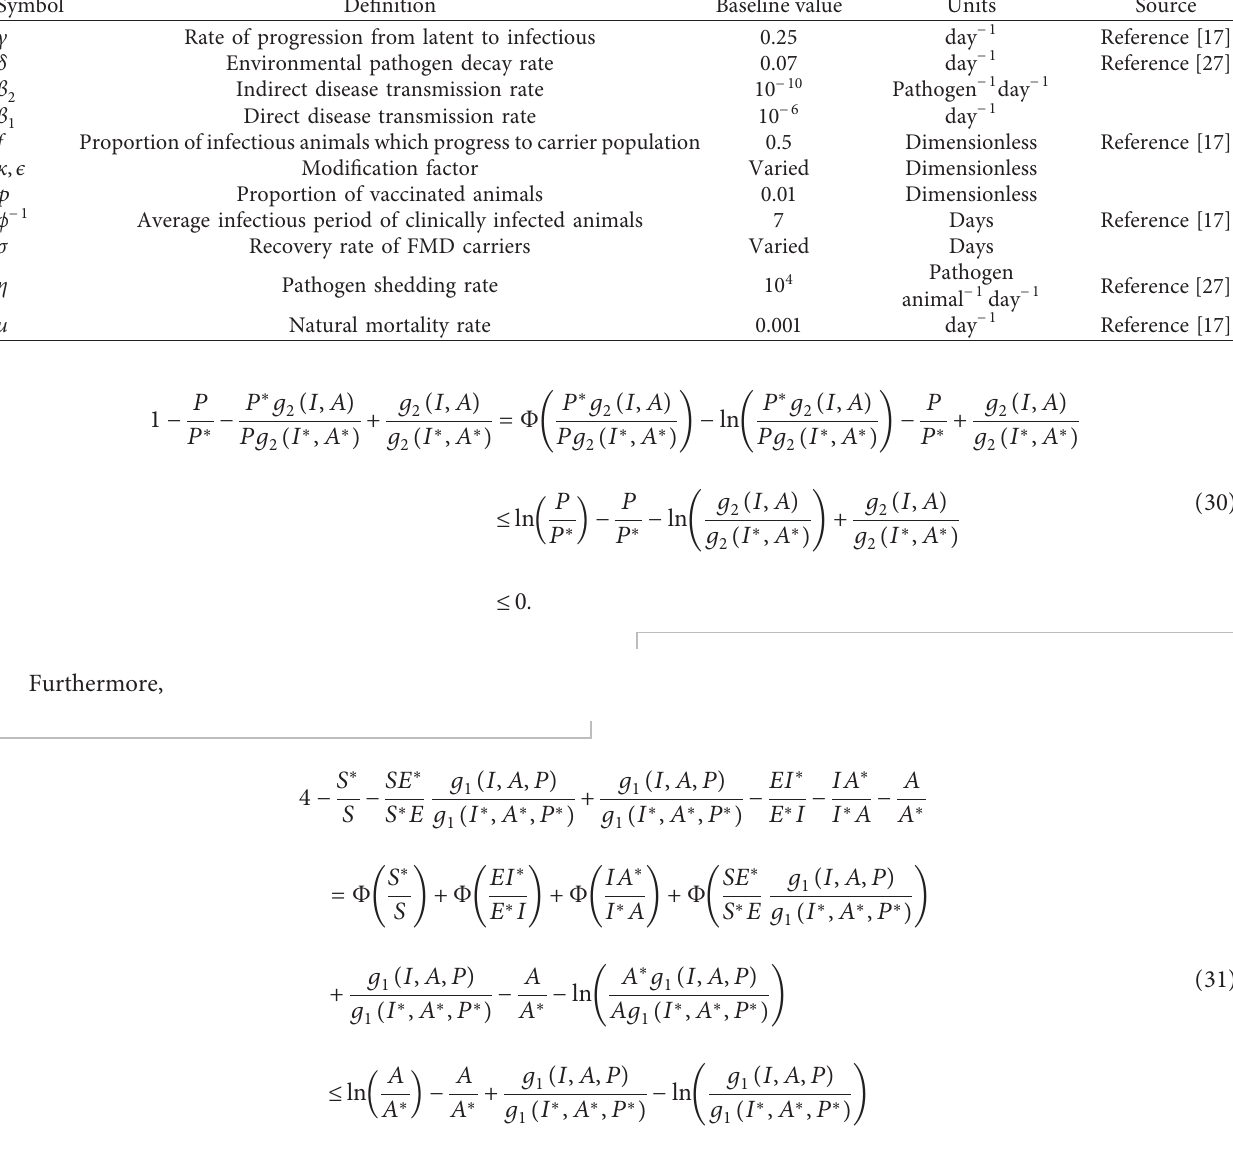
Table 1: Model parameters and their